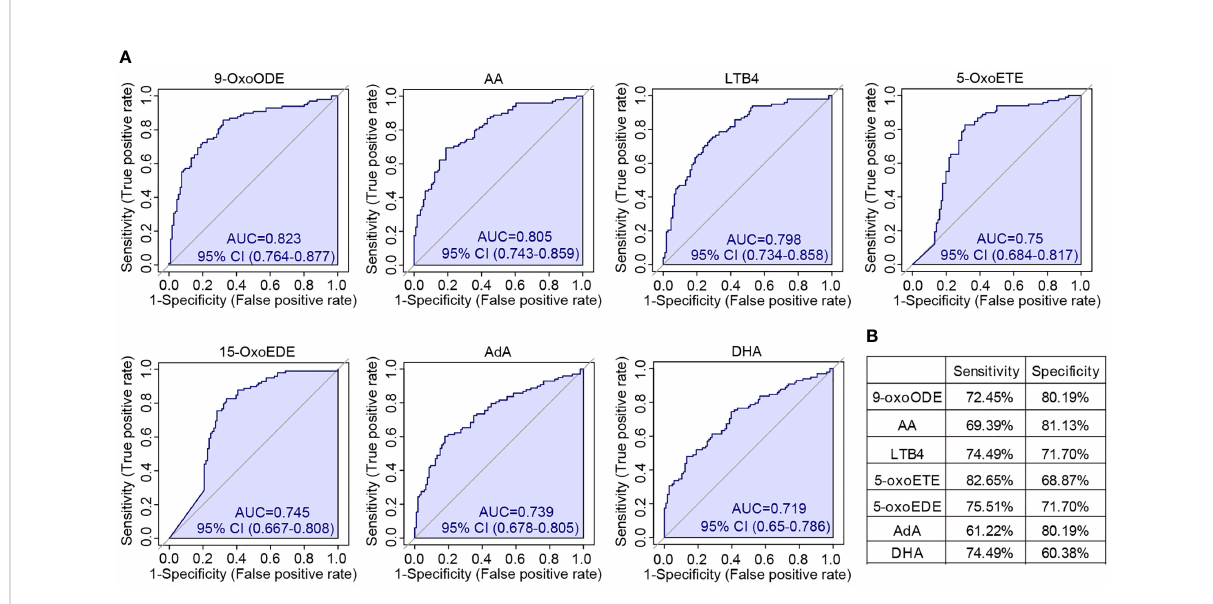
FIGURE 6 Univariate ROC analysis of individual oxylipins. (A) ROC curves showed all the oxylipins with AUC > 0.7 for the classi fi cation of SLE patients. The AUCs for different oxylipins were 0.823 (9-OxoODE), 0.805 (AA), 0.798 (LTB4), 0.75 (5-OxoETE), 0.745 (15-OxoEDE), 0.739 (AdA) and 0.719 (DHA). (B) The sensitivity and speci fi city of each seven individual oxylipin biomarkers for the detection of